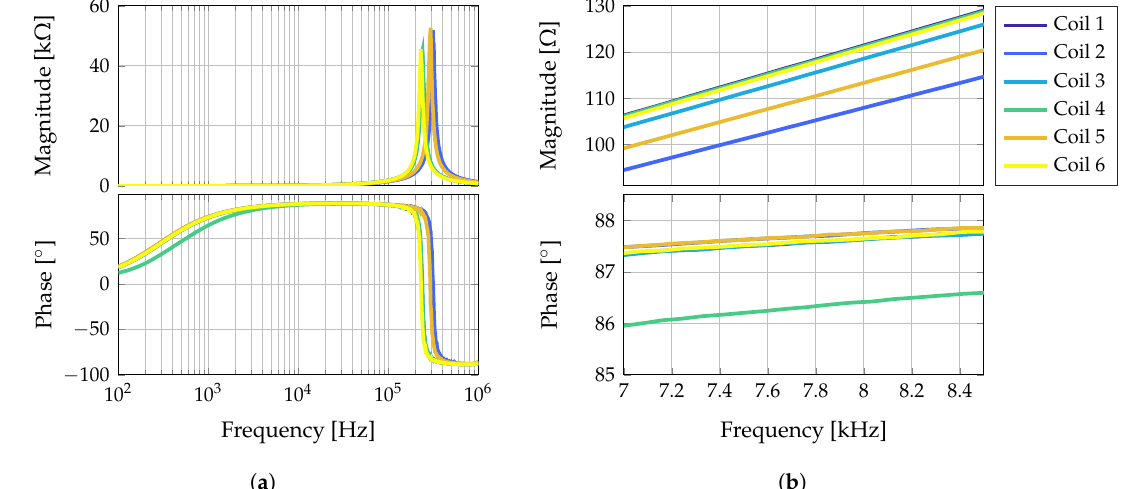
Figure 4. Coil impedances separated into magnitude and phase. In ( a ) the whole spectrum from 100Hz up to 1MHz is shown, so that the resonance of the coils can be seen. In ( b ) the frequency range is scaled to the frequency range of the excitation